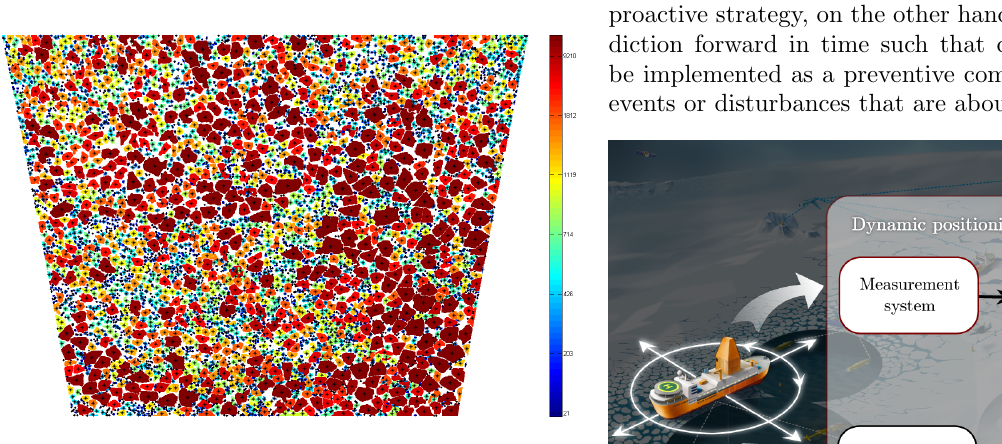
Figure 25: Identified ice floes from Figure 20 based on GVF snake algorithm, with compensation